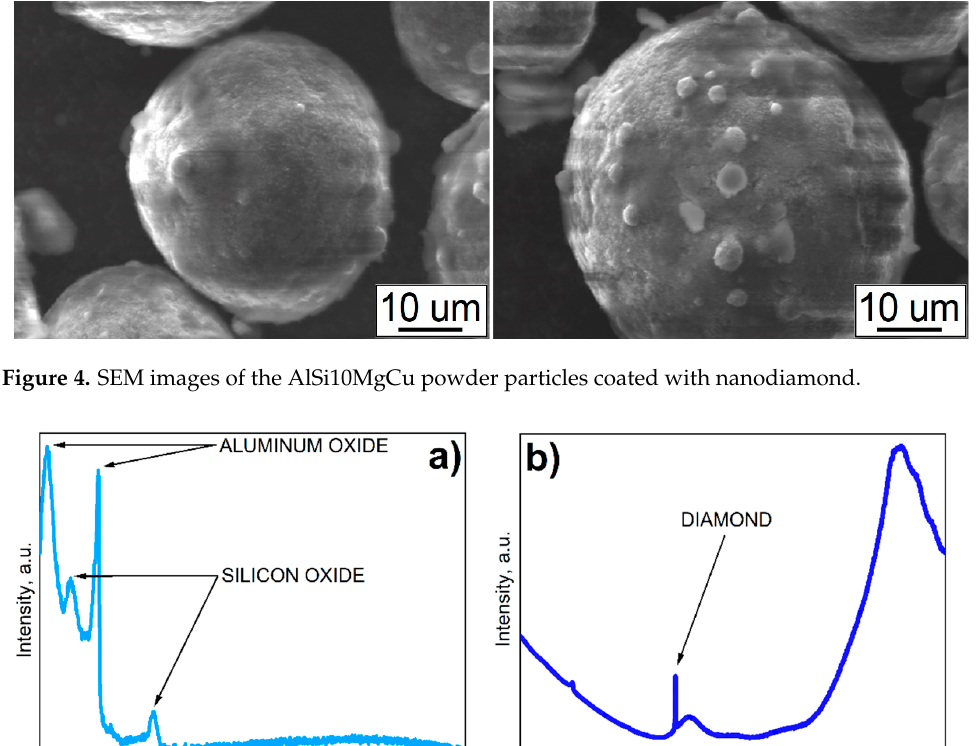
Figure 3. XRD pattern of initial nanodiamond particles.